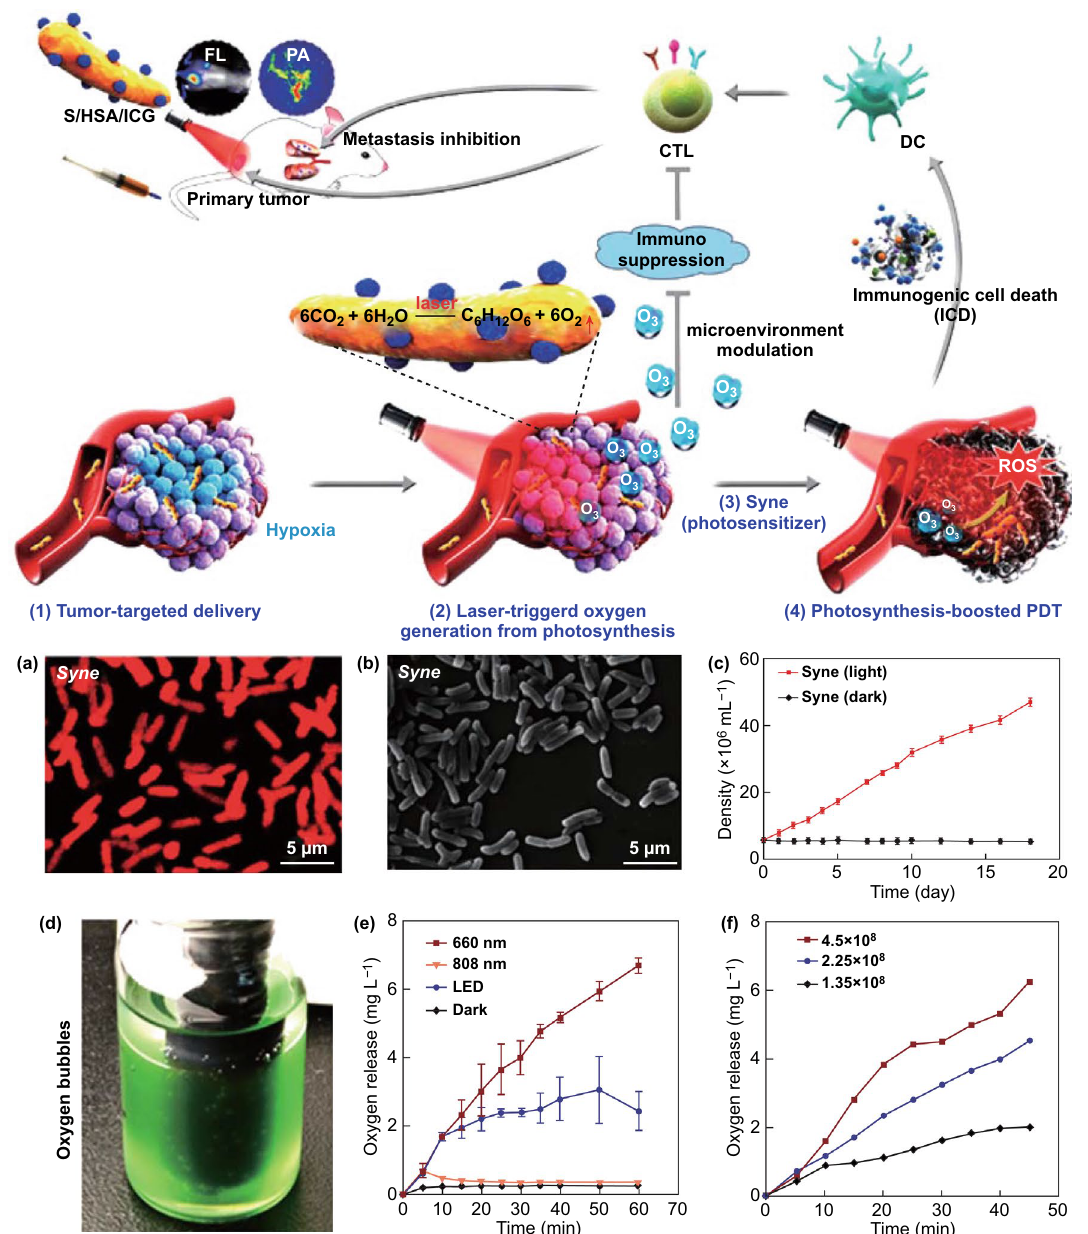
Fig. 7 Schematic of nanophotosensitizer (HSA/ICG) conjucated Syne as a photocatalyzed oxygen generation system (S/HSA/ICG) for meta- static tumor immunogenic PDT. S/HSA/ICG can target to the tumor site due to the tumor-targeting abilities of HAS and Syne. At the tumor site, Syne produced a large amount of oxygen and promote the production of ROS under laser radiation. Meanwhile, the oxygen can ameliorate tumor hypoxia and reverse the tumor immunosuppressive microenvironment, and further elicit the immunogenic cell death-mediated antitumor immune response to enhance the PDT efficacy. a FL micrograph of Syne. b Scanning electron micrograph of Syne. c Growth curve of Syne. d Bubbles generated in the Syne suspension under light. e Oxygen release curves of Syne of various conditions. f Oxygen production curves of dif- ferent concentrations of Syne under 660 nm laser irradiation. Reprinted with permission from Ref.